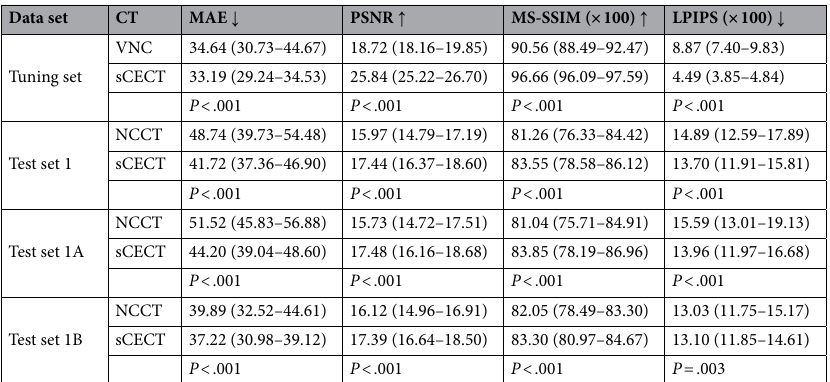
Table 2. Evaluation of quantitative similarity metrics. Note Data are median (interquartile range). Lower MAE, higher PSNR, higher MS-SSIM, and lower LPIPS values indicate higher image similarity. VNC = virtual non-contrast CT, sCECT = synthetic contrast-enhanced CT, NCCT = non-contrast CT, MAE = mean absolute error, PSNR = peak signal-to-noise ratio, MS-SSIM = multiscale structural similarity index measurement, LPIPS = learned perceptual image patch similarity